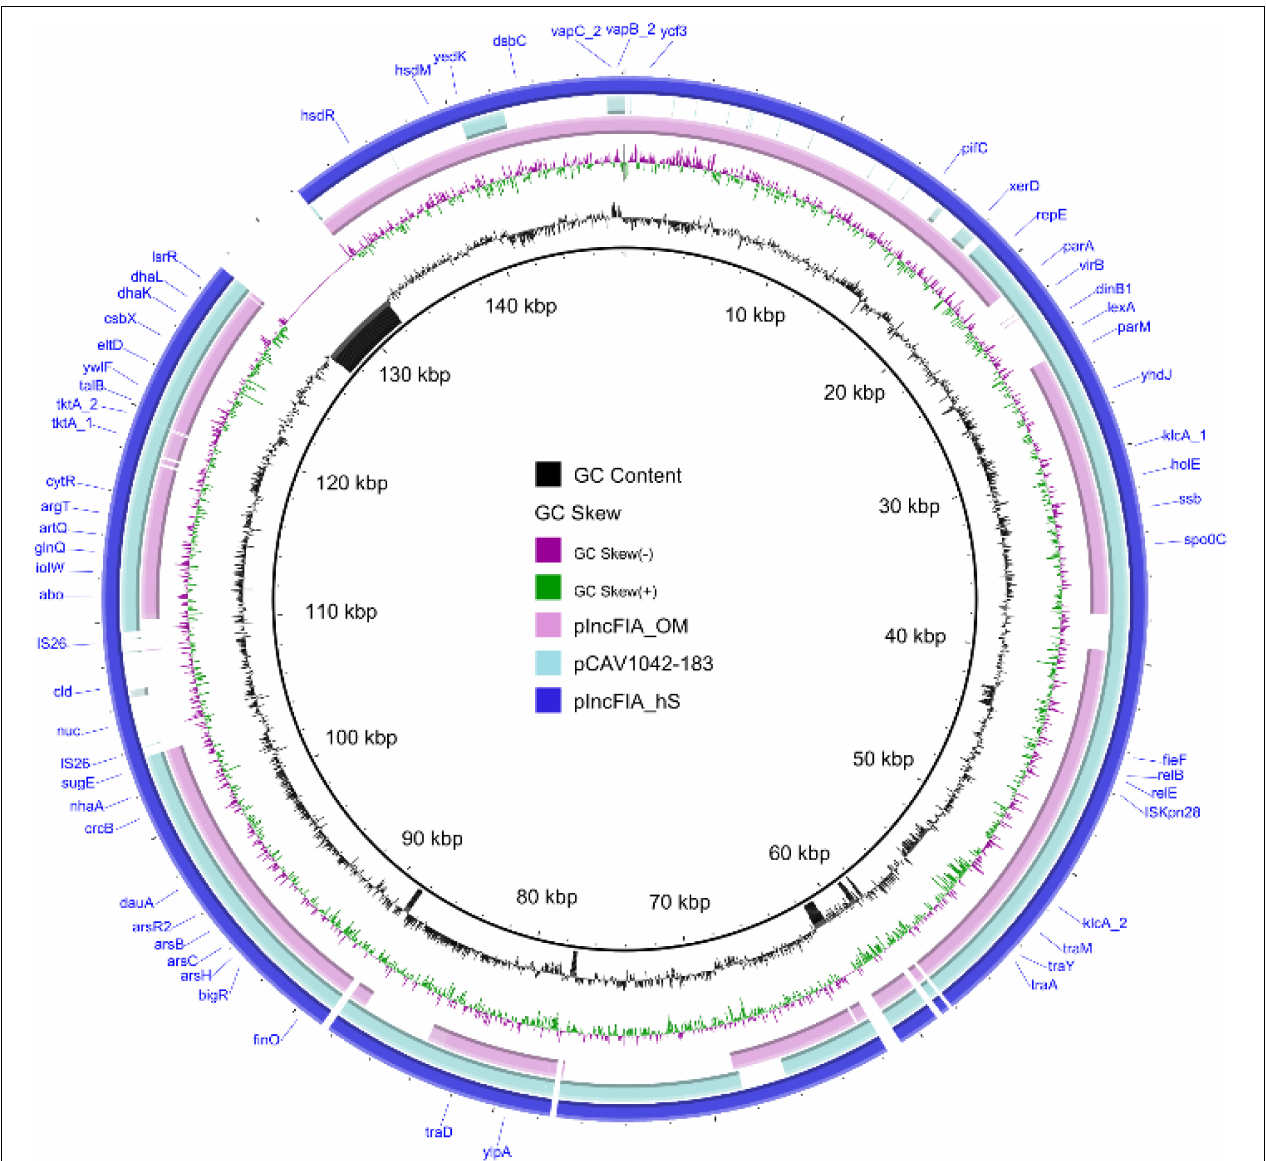
FIGURE 8 | Map of the largest observed new completed circular plasmid sequence using hybrid assembly methods, hybridSPAdes, and OPERA-MS. Plasmids pIncFIA_hS, pIncFIA_OM, and pCAV1042_183 are plotted in the figure using the sequence of pIncFIA_hS as a